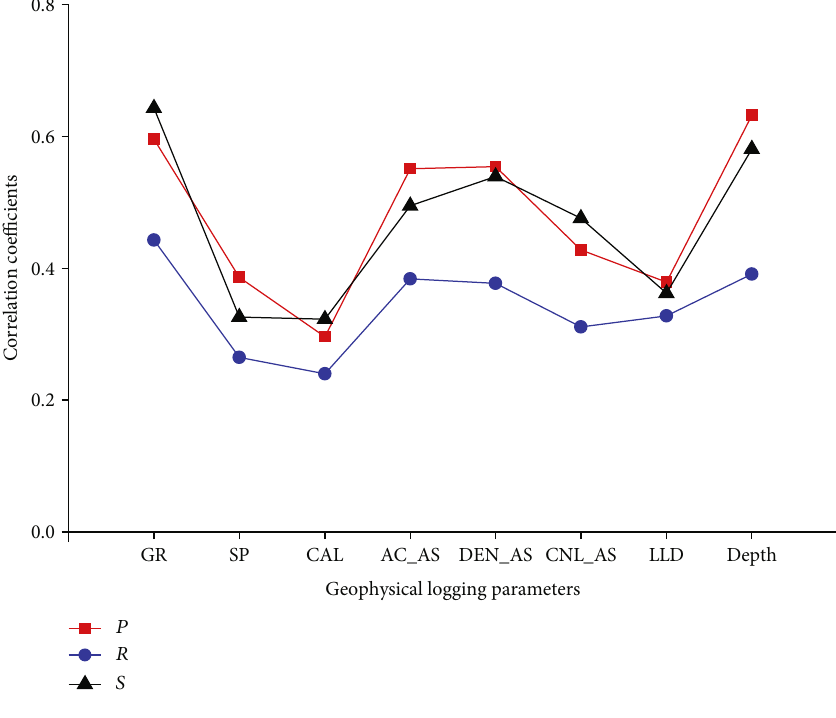
Figure 12: Correlation between the logging curves and the CBM content.